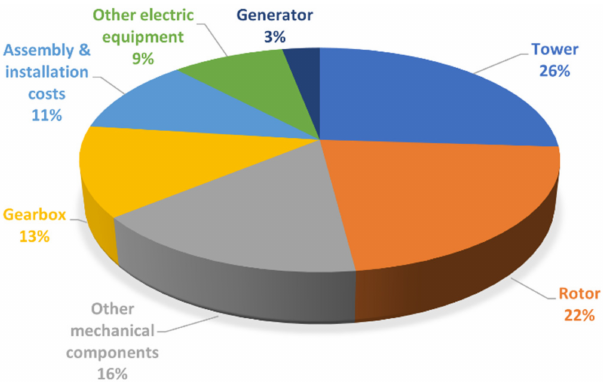
Figure 3. Estimated costs of a HAWT, as a percentage of the total and excluding foundations. Based on data retrieved from Ref.